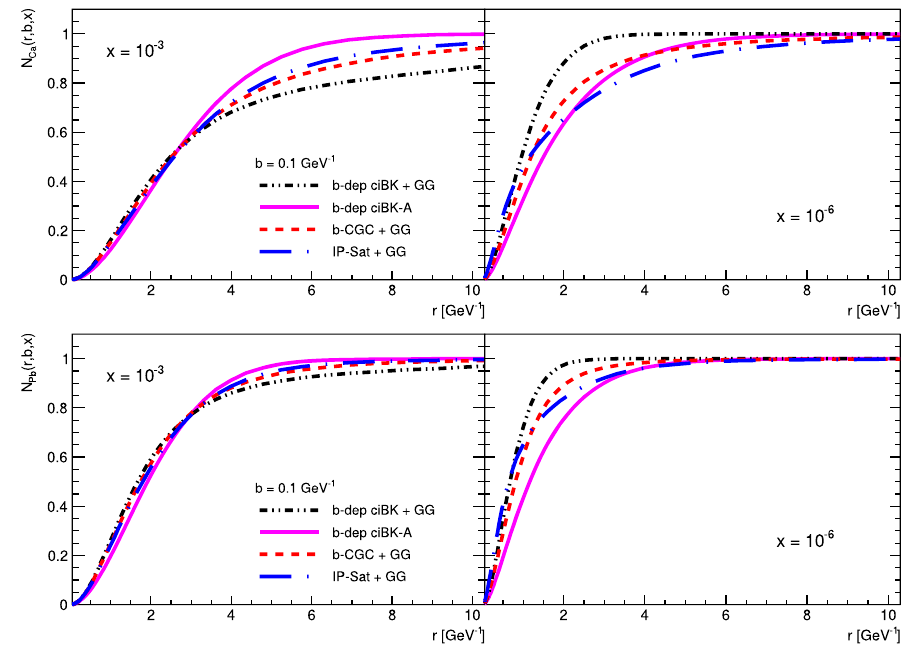
Fig. 4 Dipole-nucleus scattering amplitude for a fixed impact parameter b = 0 . 1 GeV − 1 and two values of x